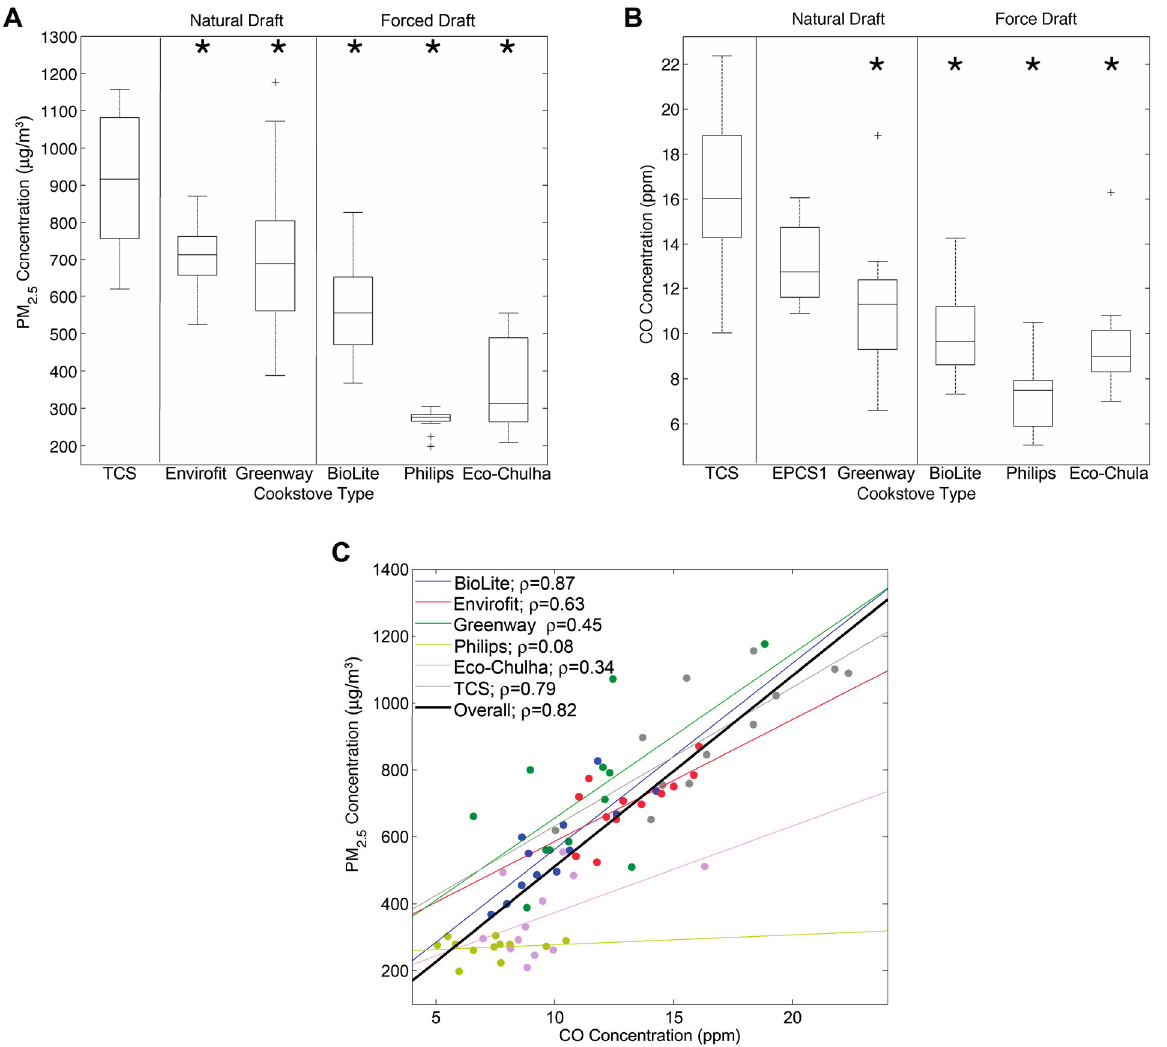
Figure 1. PM 2.5 and CO concentrations generated from cookstoves. ( A ) Box plots depicting PM 2.5 concentrations for the traditional cookstove (TCS), natural draft ACSs (Envirofit and Greenway), and forced draft ACSs (BioLite, Philips, and Eco-Chulha). Box plots are calculated from the average PM 2.5 concentrations during each 1 h cooking event ( n = 12 per stove). ( B ) CO concentrations for the same cooking events as in (A). ( C ) Correlations between PM 2.5 and CO concentrations were expressed as the Spearman’s rank correlation coefficient and linear regression for each cookstove. * p <